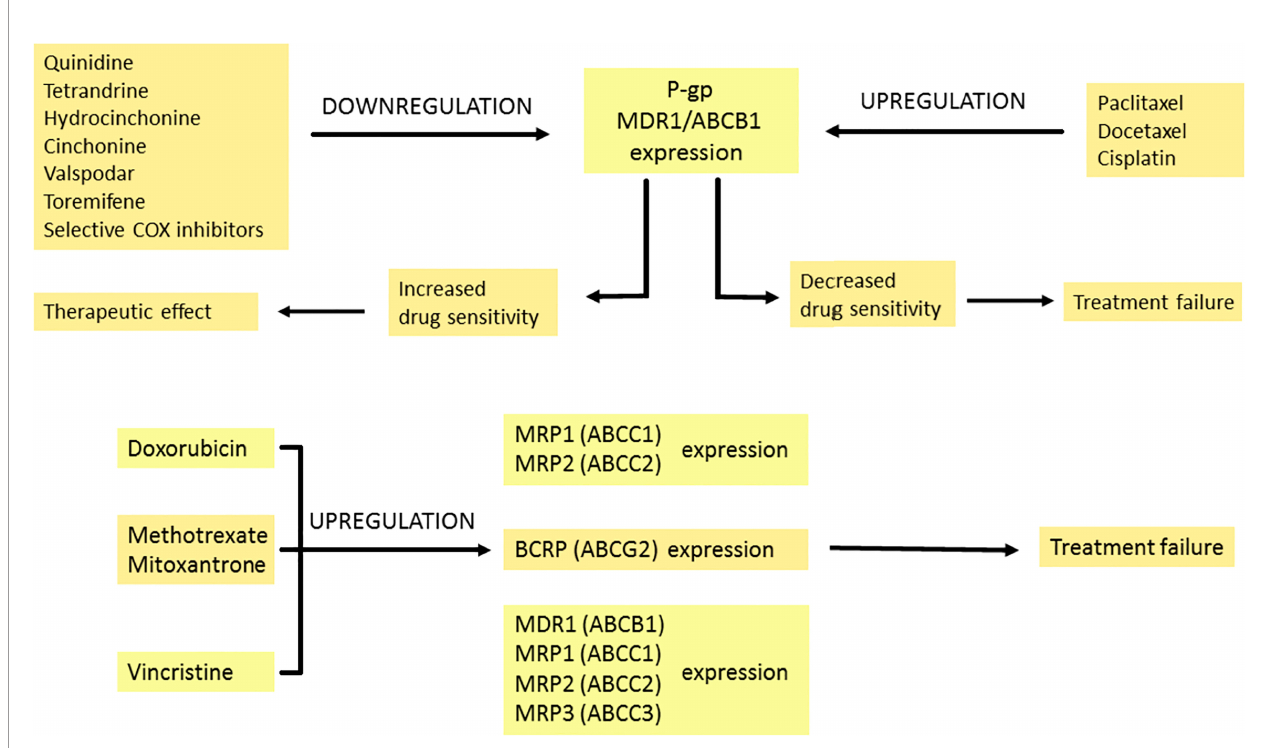
FIGURE 3 | The modulation of multidrug resistance proteins by pharmacotherapy. Expression of P-GP can be increased or decreased by many drugs. Quinidine, tetrandrine, hydrocinchonine, cinchonine, valspodar, toremifene and selective COX inhibitors downregulate P-GP expression, which leads to enhanced transport of the drug into tumour cells and therapeutic effect. In contrast, when the expression of P-GP is downregulated by paclitaxel, docetaxel and cisplatin, it is connected with decreased drug sensitivity and treatment failure. Doxorubicin ampli fi es MRP1 and MRP2 expression. Methotrexate and mitoxantrone intensify BCRP expression. Vincristine upregulates MDR1, MRP1, MRP2 and MRP3 expression. The modulation effects described above are associated with reduced treatment response. Breast Cancer Resistance Protein (BCRP), P-glycoprotein (P-GP), cyclooxygenase (COX), multidrug resistance 1 (MDR1), multidrug resistance-associated protein 1-3